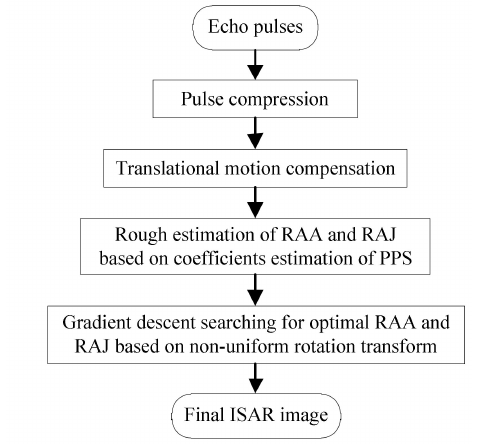
Figure 2. Procedure of new ISAR imaging approach for targets with complex motion.